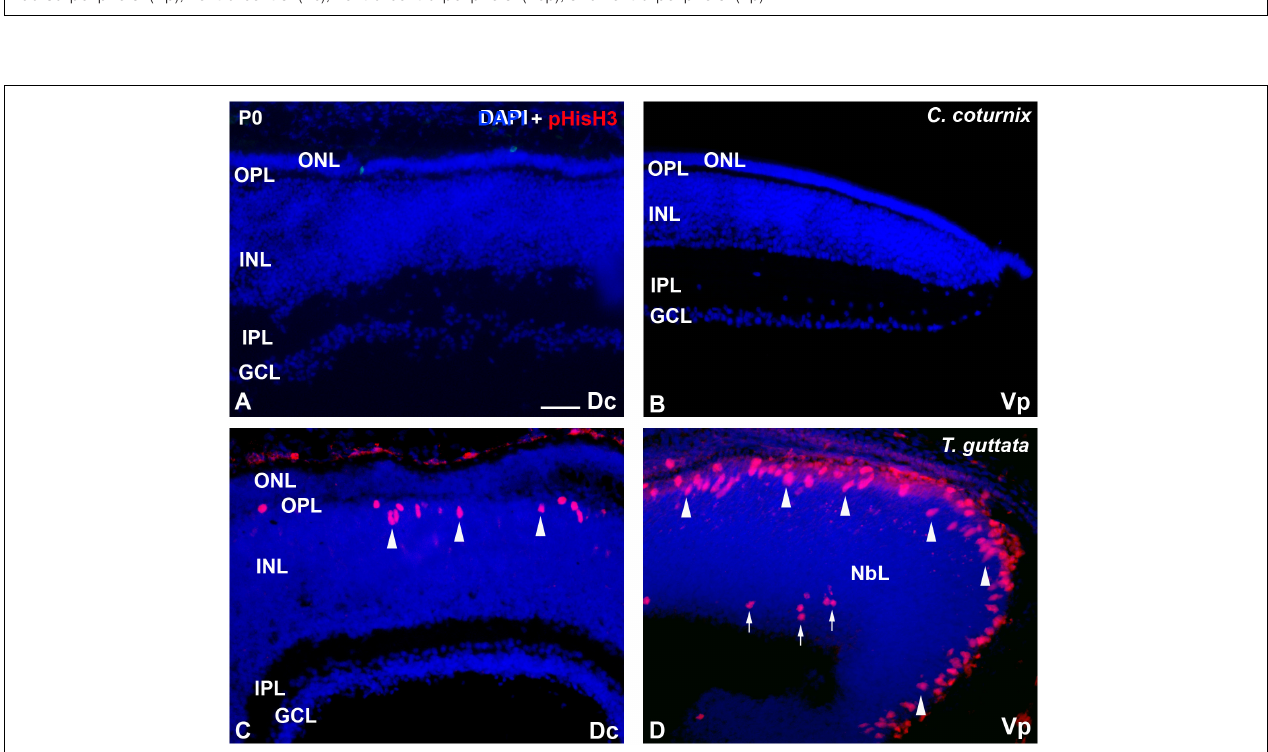
FIGURE 2 | Patterns of pHisH3 immunoreactivity Dc (A,C) and Vp regions (B,D) of the C. coturnix (A,B) and T. guttata (C,D) retina at hatching. Cryosections were counterstained with DAPI. (A,B) Immunoreactive mitotic figures were totally absent from the C. coturnix retina. (C,D) pHisH3-immunoreactive mitoses were mainly located in the vitreal surface (arrowheads) in the T. guttata retina. Furthermore, non-apical mitoses were also found in the Vp sector (arrows). Abbreviations: GCL, ganglion cell layer; INL, inner nuclear layer; IPL, inner plexiform layer; NbL, Neuroblastic layer; ONL, outer nuclear layer; OPL, outer plexiform layer. Scale bar: 25 µ m.